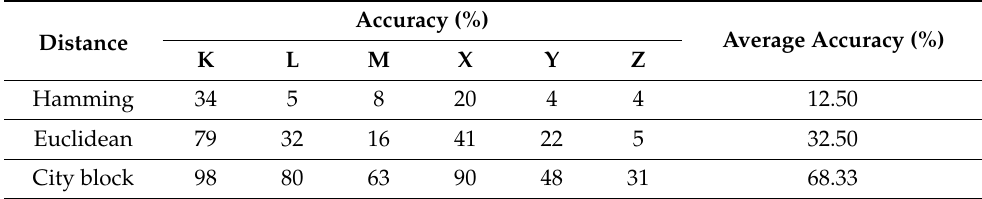
Table 6. Comparison of the results obtained using different distances with occlusion by scarf.